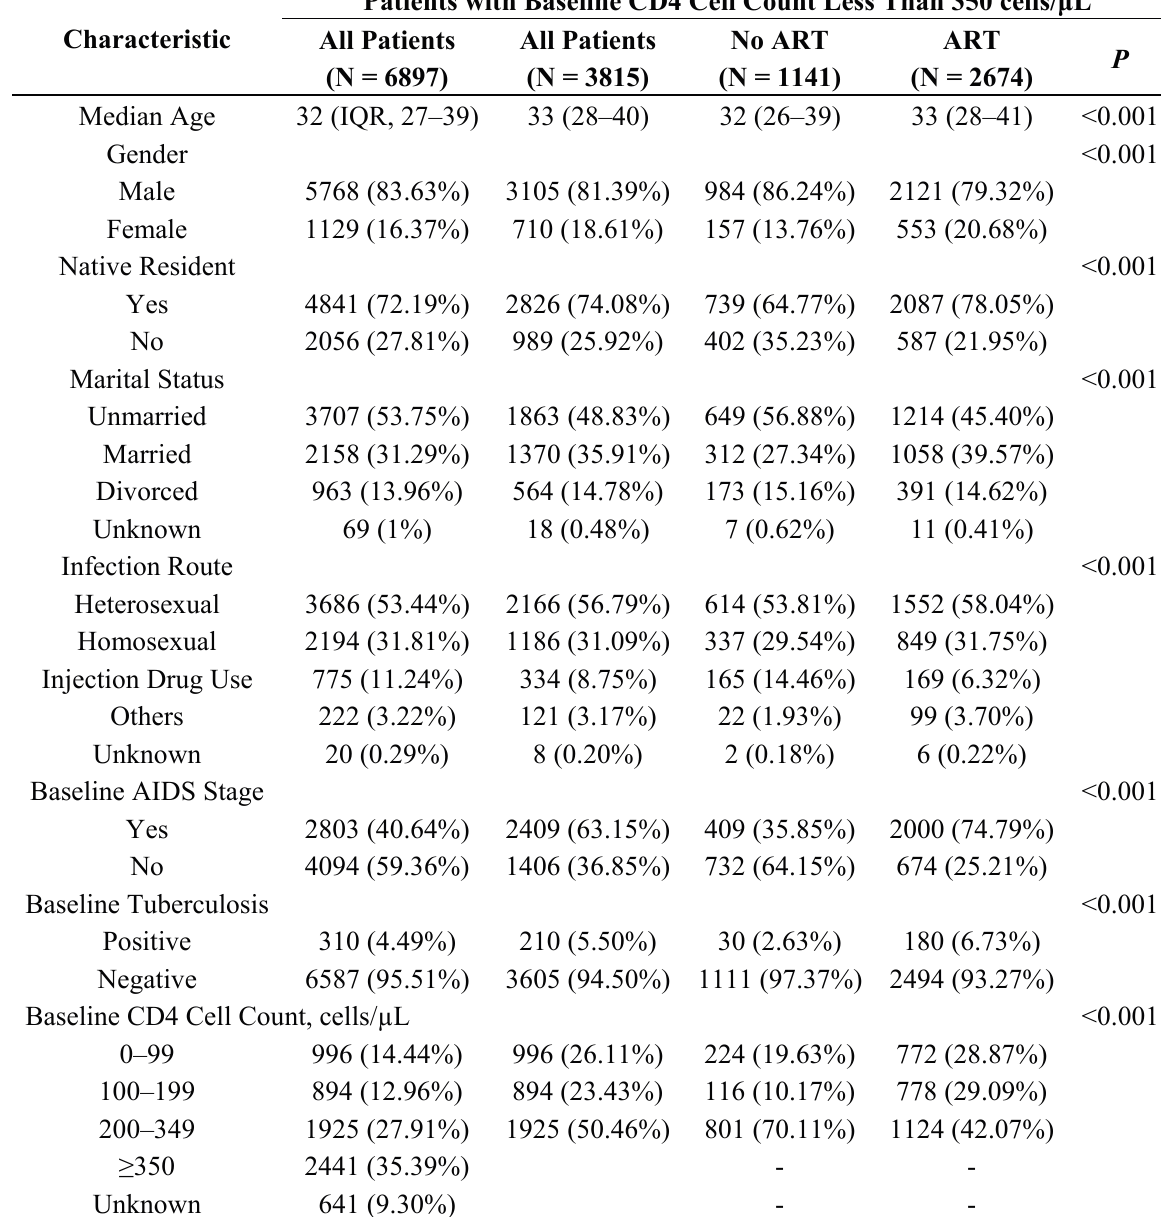
Abbreviation: ART, antiretroviral